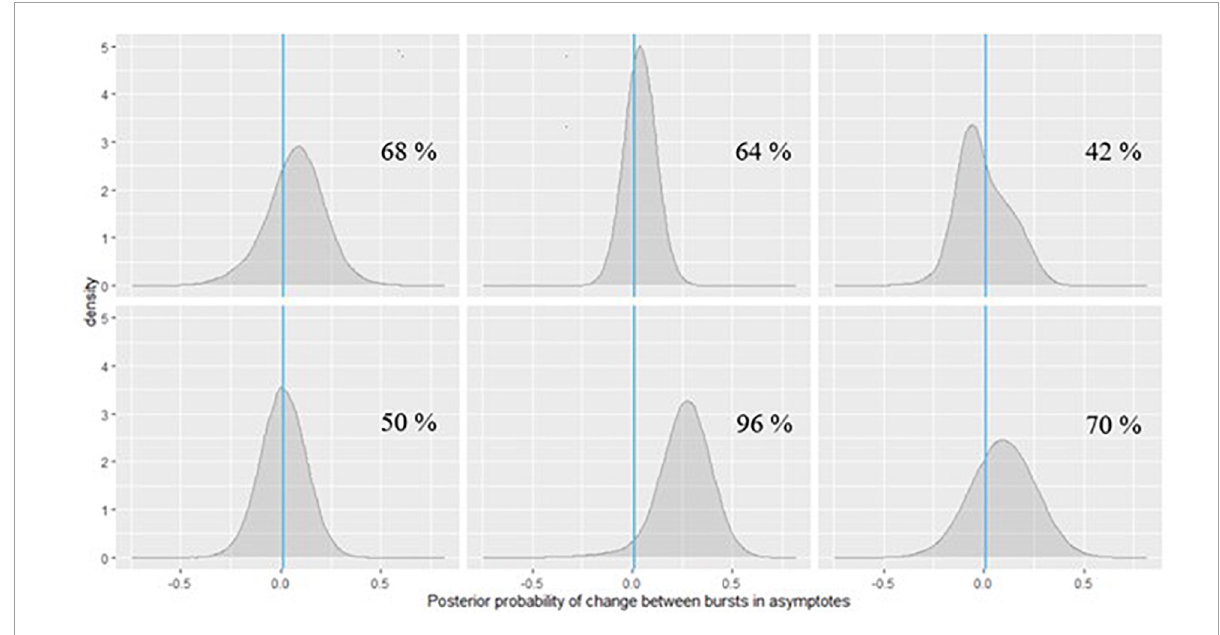
FIGURE10 Posterior probabilities of change in the symbol search task performance for 6 EAS participants.